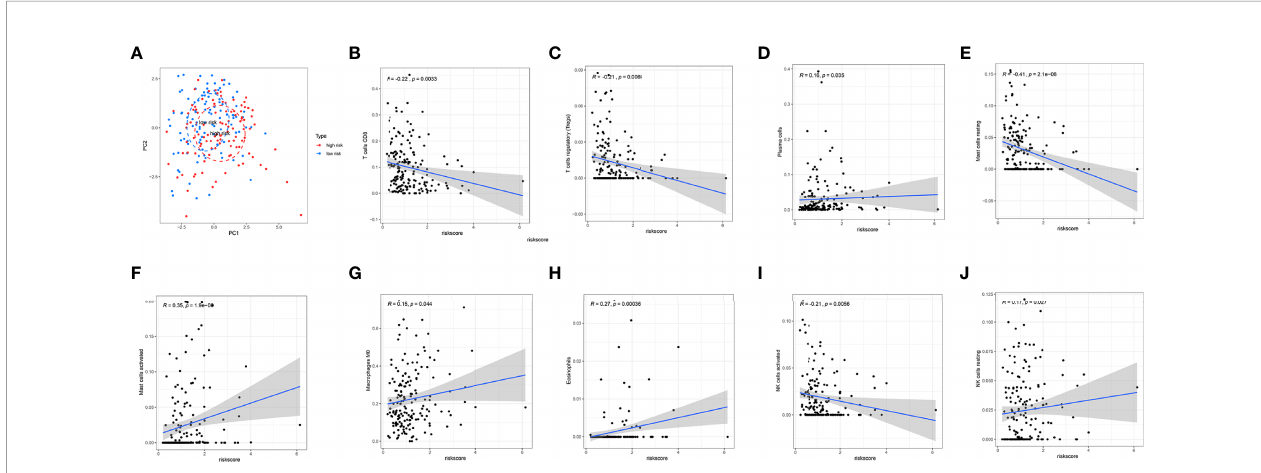
FIGURE 7 | Correlation analysis of immune cell in fi ltration and risk scores. (A) PCA analysis showed a distinct immune cell in fi ltration pattern in two groups. (B – J) Correlation analysis of risk scores and nine types of the immune